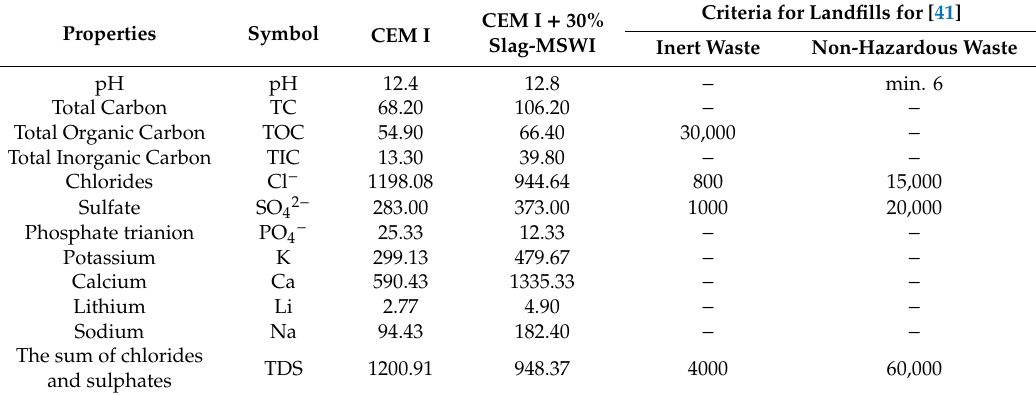
Table 13. Leachability of selected contaminants from crushed mortar, expressed in mg / kg (with pH